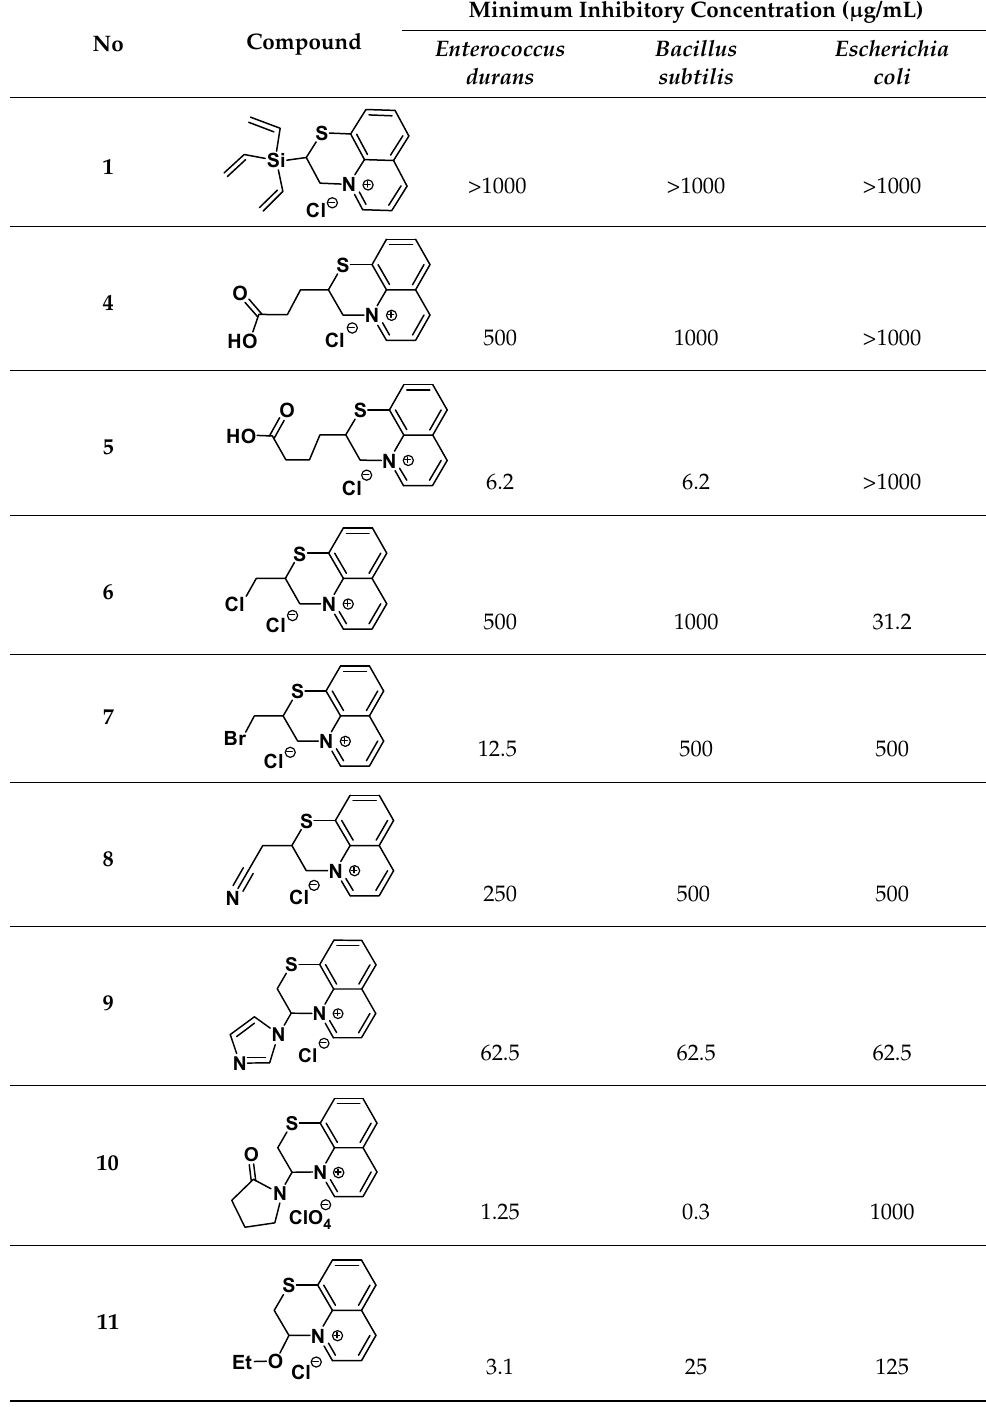
Table 1. Evaluation of the antibacterial activity of compounds 1 , 4 – 13 . No